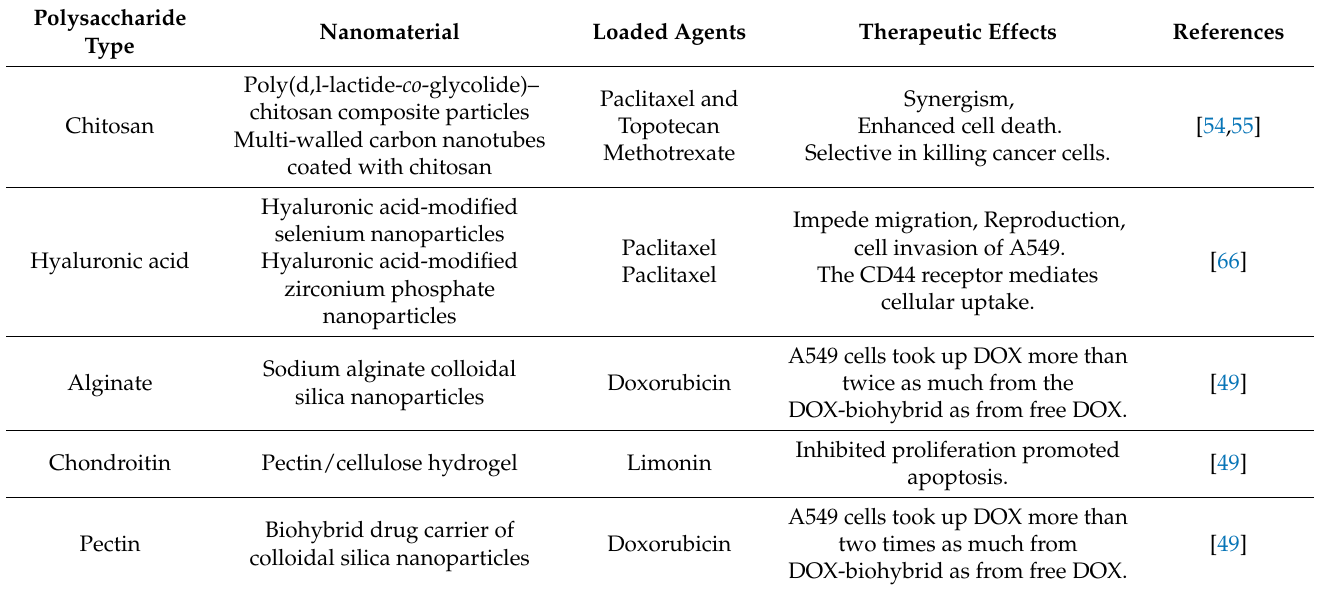
Table 2. Nanoparticles derived from polysaccharides as delivery vehicles for lung cancer